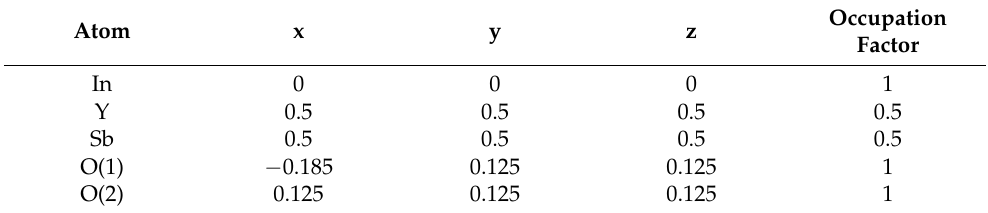
Figure 2. Atomic structure of In 2 YSbO 7 . (Red atom: O; cyan atom: In; purple atom: Y or Sb.). Table 1. Structural parameters of In 2 YSbO 7 synthesized by solvothermal method. Atom